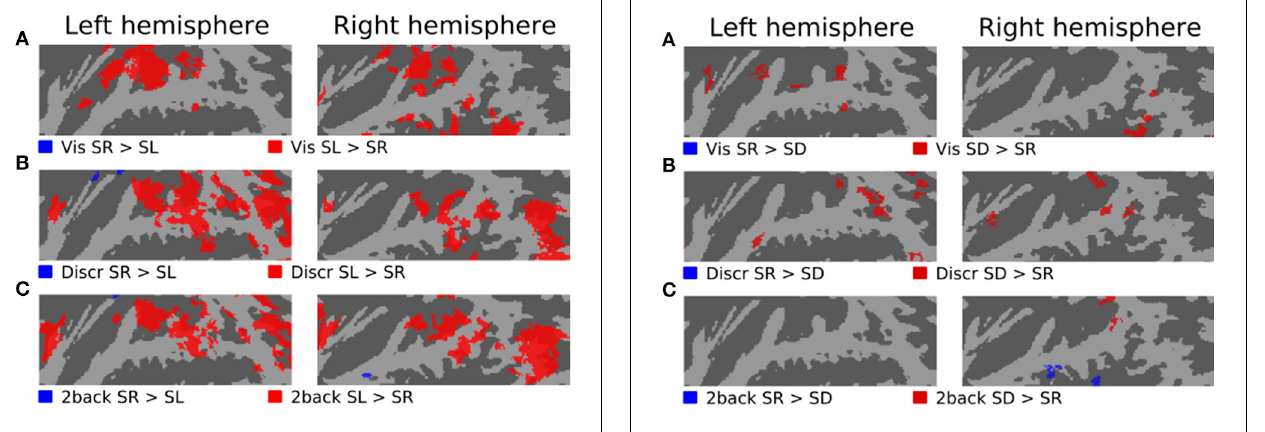
FIGURE 4 | Comparisons of activations during visual, discrimination and 2-back tasks with SR and SL sounds.